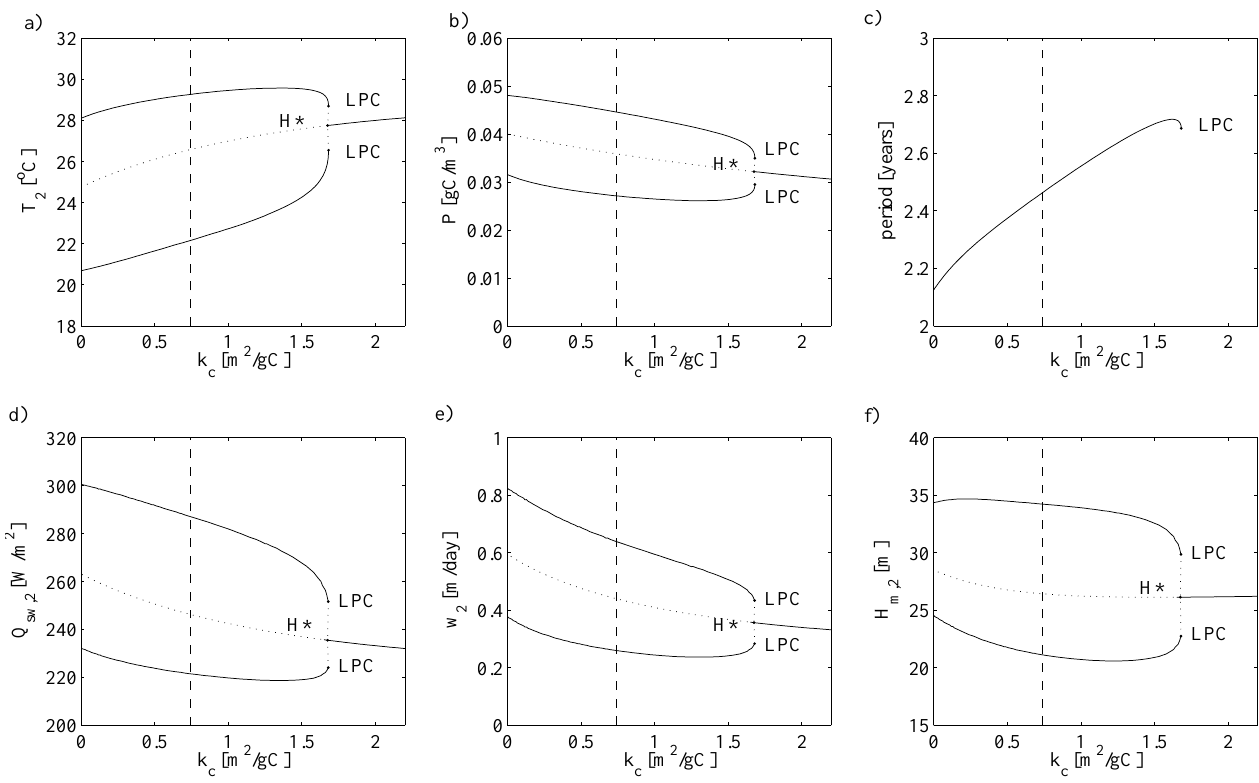
Fig. 4. Variations in response to changes of the biomass-specific self-shading coefficient k c for (a) eastern SST T 2 , (b) eastern phytoplankton concentration P, (c) ENSO period, (d) incoming short-wave heatflux Q sw , 2 , (e) upwelling velocity w 2 , and (f) eastern mixed layer depth H m , 2 ; H ∗ : subcritical Hopf bifurcation; LPC: limit point of cycles; solid lines: minimum and maximum of stable oscillation or stable steady state respectively; dotted lines: minimum and maximum of unstable oscillation or unstable steady state; dashed line: default value k c = 0 . 74m 2 (gC) − 1 .